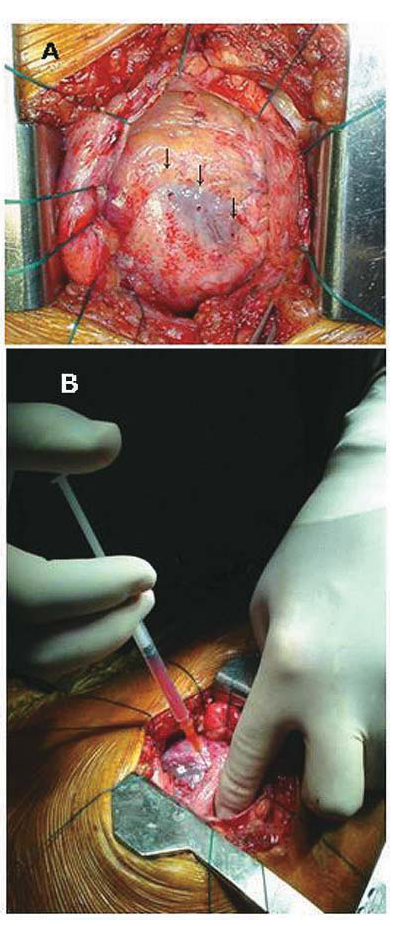
Fig. 1 - A - Canais criados pelos disparos de laser na parede anterior do VE (setas). B - Injeção intramiocárdica de CPH combinada à